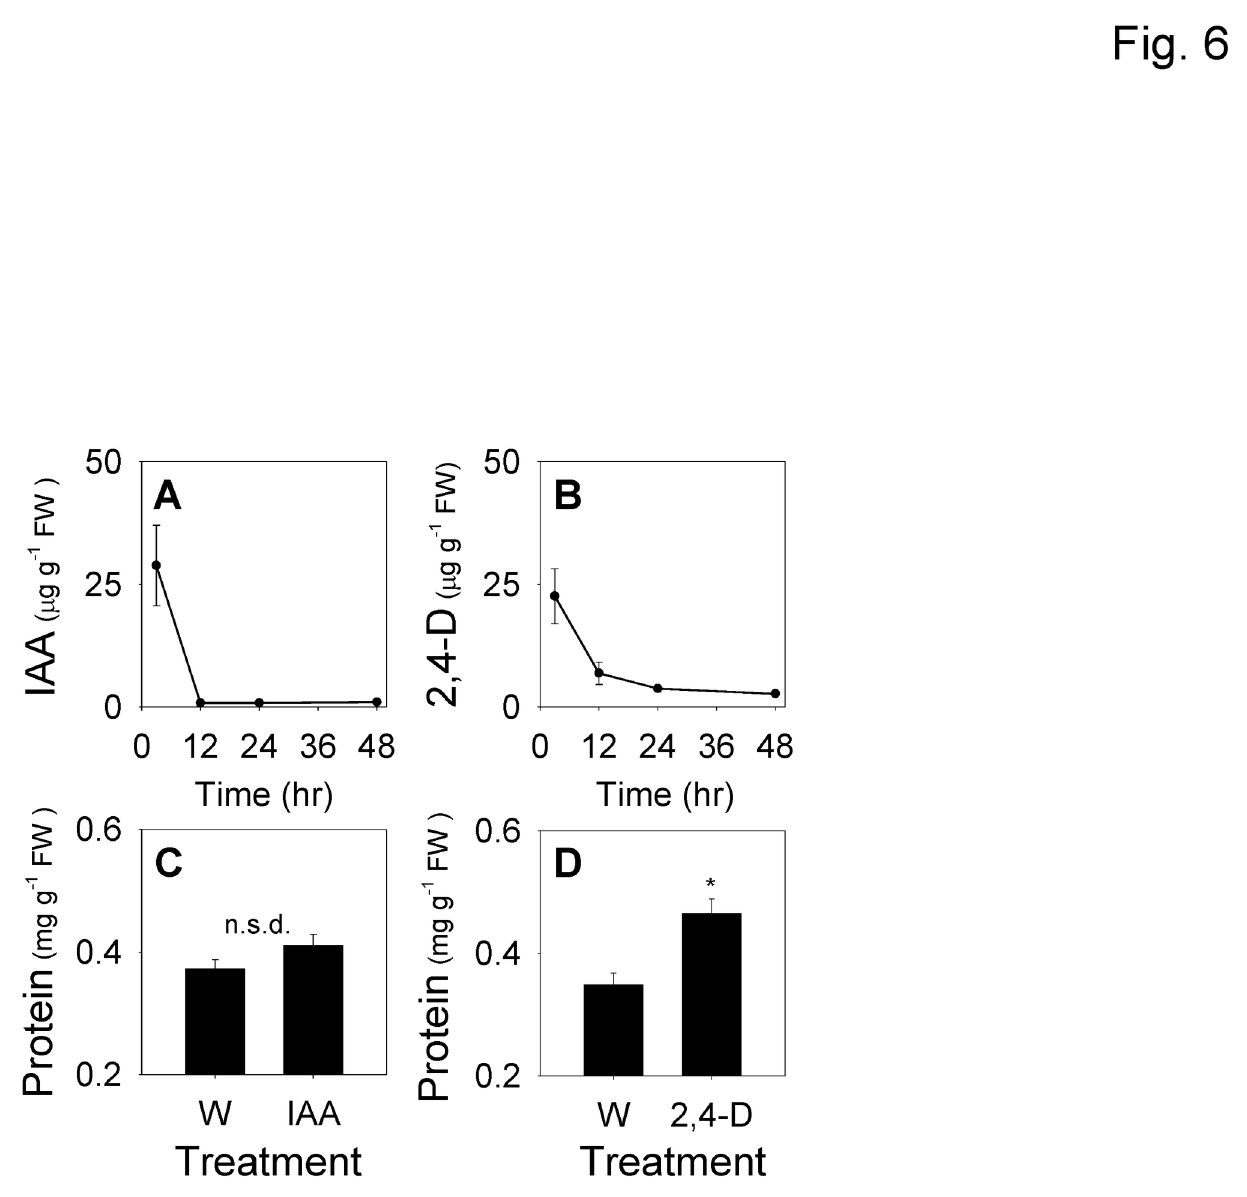
Figure 6. Prolonged exposure to a synthetic stable auxin increases total protein levels in maize stem tissue. Average ( n = 4, ±SEM) auxin levels of A , indole-3-acetic acid (IAA) and B , 2,4-dichlorophenoxyacetic acid (2,4-D) following a 50 µg application to wounded (W) stems and subsequent harvests at 3, 12, 24, and 48 h after treatment. Average ( n = 6, +SEM) total soluble protein extracted at 48 h from maize stem tissue treated with 50 µg C , IAA or D , 2,4-D. Significant differences are indicated by asterisk (Student’s t -test, P < 0.05; n.s.d = no statistical difference). doi: